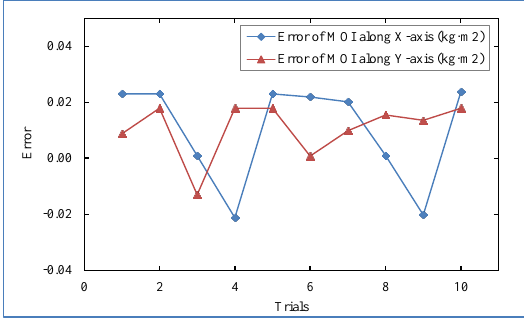
Figure 21. Standard sample MOI measurement error.